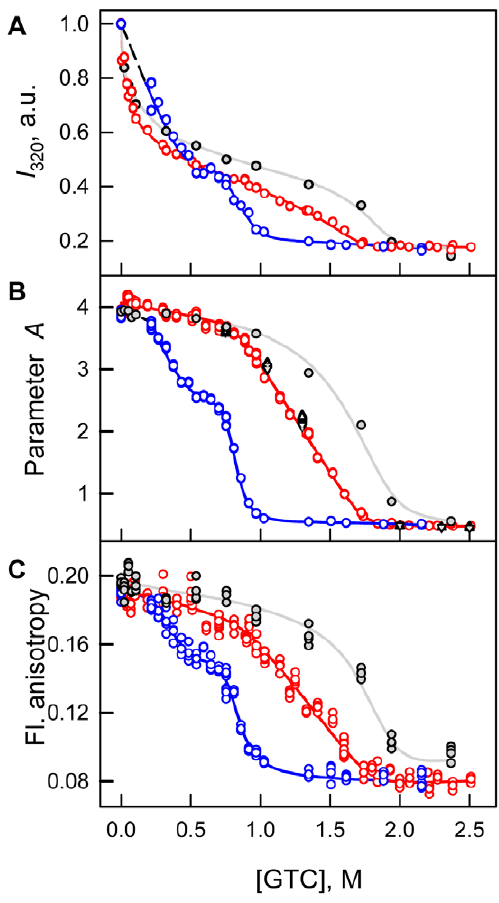
Figure 4. Conformational changes of sfGFP induced by GTC. ( A ) Changes in fluorescence intensity recorded at 320 nm. ( B ) Changes of parameter A . ( C ) Changes of fluorescence anisotropy at emission wavelength of 365 nm. l ex ~ 297 nm . Red circles and line indicate unfolding and blue circles and line represent refolding. Measurements were performed after 24 h incubation of native or denatured protein in the GTC presence. The values of parameter A of sfGFP measured after incubation of native protein in the GTC presence during 1 h (gray circles and line), 45 h (black triangles), 69 h (reversed gray triangles) and 94 h (gray crosses) are also